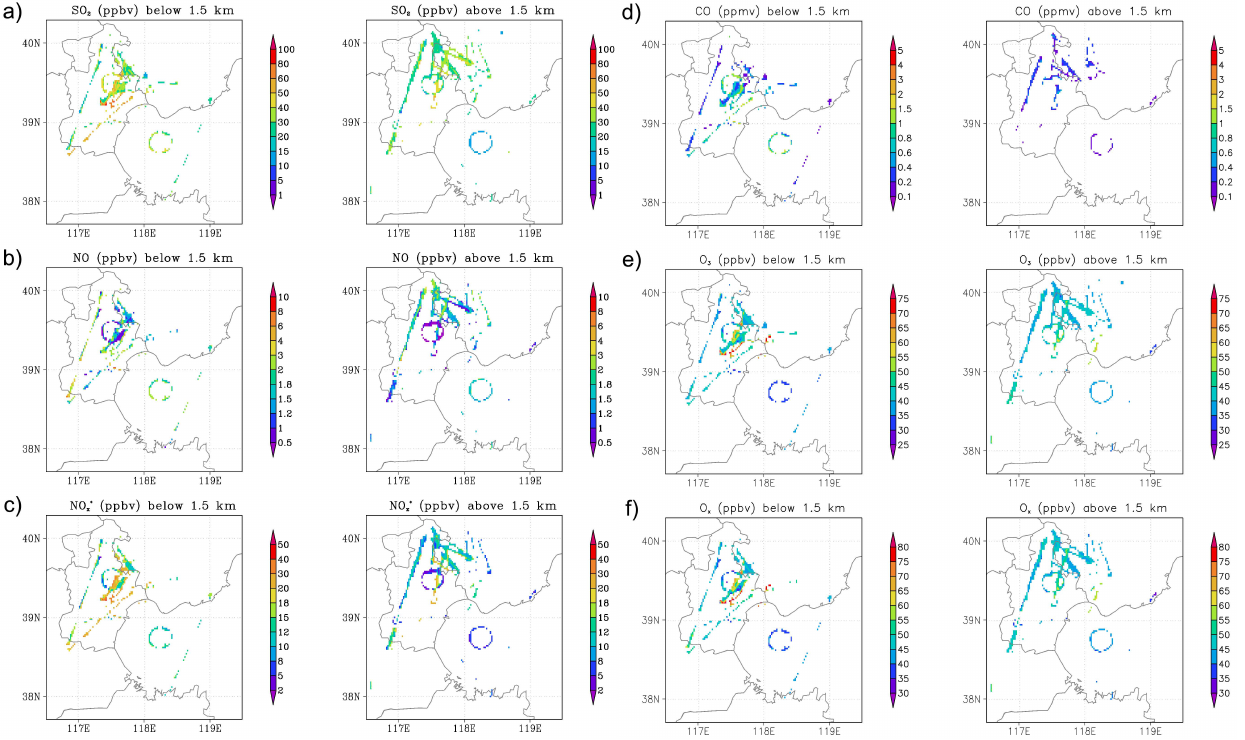
Fig. 9. Flight track of all data collected from the aircraft below (left) and above (right) 1.5km colored by (a) SO 2 , (b) NO, (c) NO ∗ x , (d) CO, (e) O 3 , and (f) O x mixing ratios during